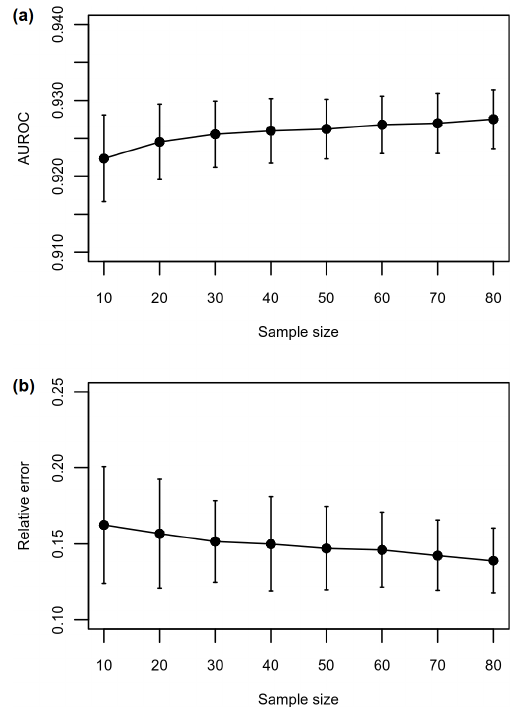
Figure 14. Comparison of runout path (a) and distance (b) perfor- mance for different model training samples sizes assessed using spatial cross-validation. The error bars indicate the standard devi- ation in